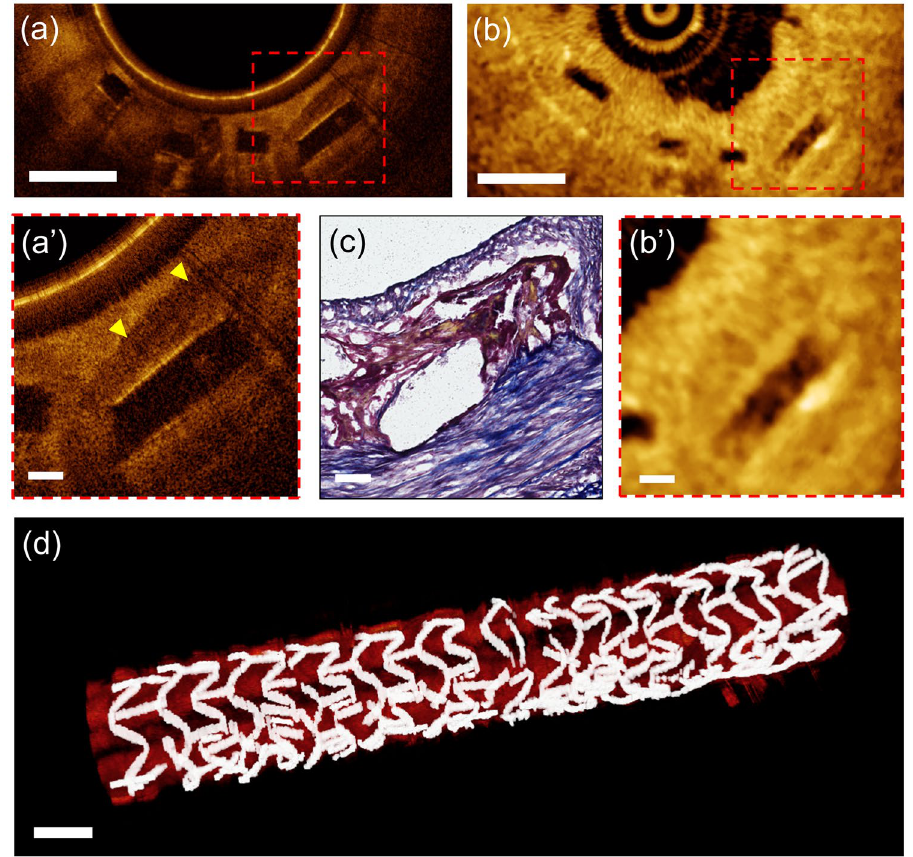
Figure 6. Imaging results of a swine coronary artery that received two overlapping BVSs (28 days post- implantation). ( a,a’ ) µ OCT image clearly demonstrating a peri-strut low-intensity area with well-defined margin (yellow arrowheads); ( b,b’) Corresponding cross-section acquired using conventional OCT; ( c ) Histologic section shows excessive fibrin deposition around strut (Verhoeff elastic-Masson trichrome stain). ( d ) A three-dimensionally reconstructed image of BVSs-implanted swine coronary artery (28 days post- implantation) showing multiple fractured struts. Three-dimensional volume rendering was performed using OsiriX (The OsiriX Foundation, Geneva, Switzerland). Scale bars for a , b , and d 500 μ m. Scale bars for a’, b,’ and c 100 μ